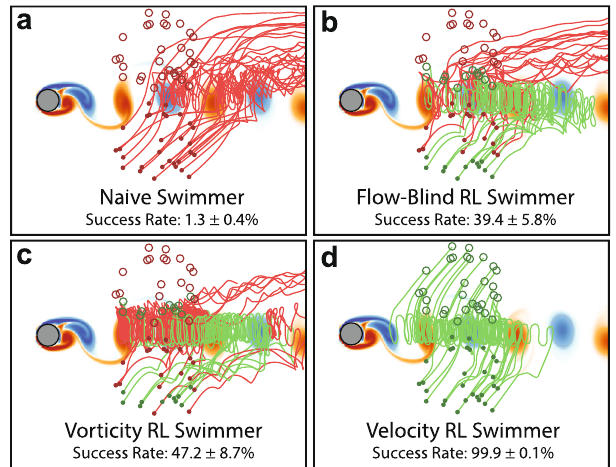
Fig. 4, and are compared with a naive policy of simply swimming